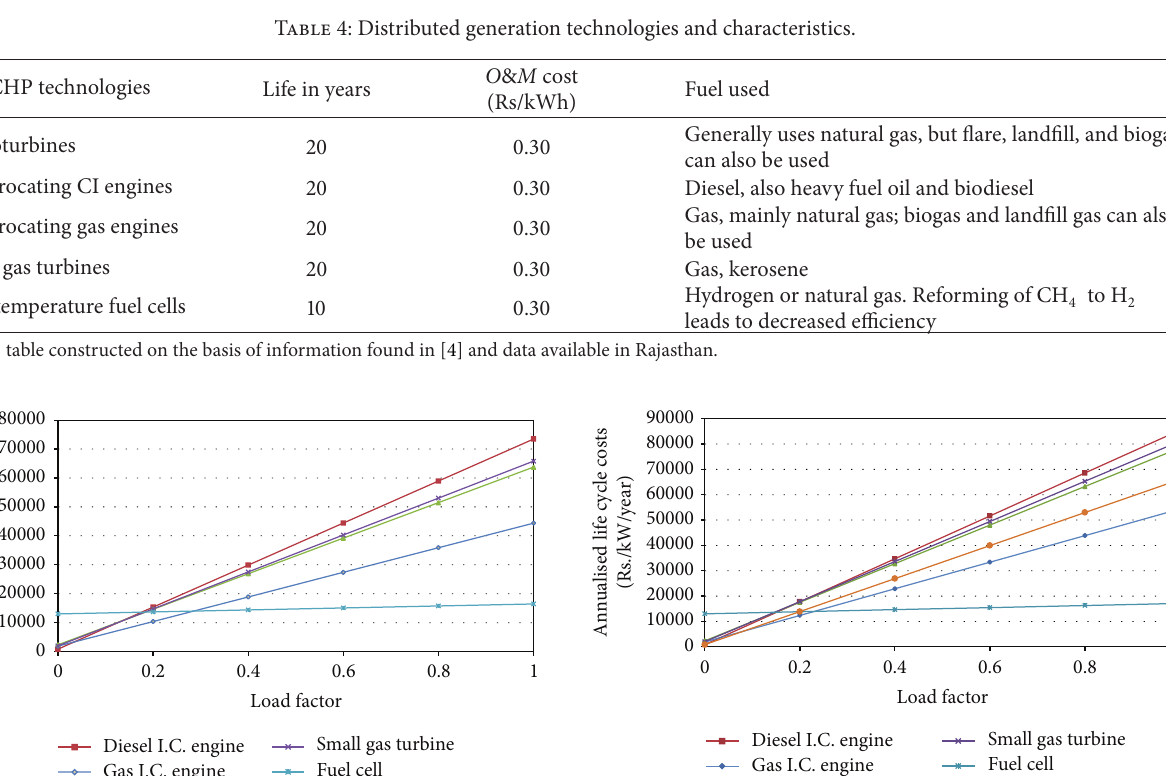
Source: table constructed on the basis of information found in [4, 5] and data available in Rajasthan. Table 4: Distributed generation technologies and characteristics.